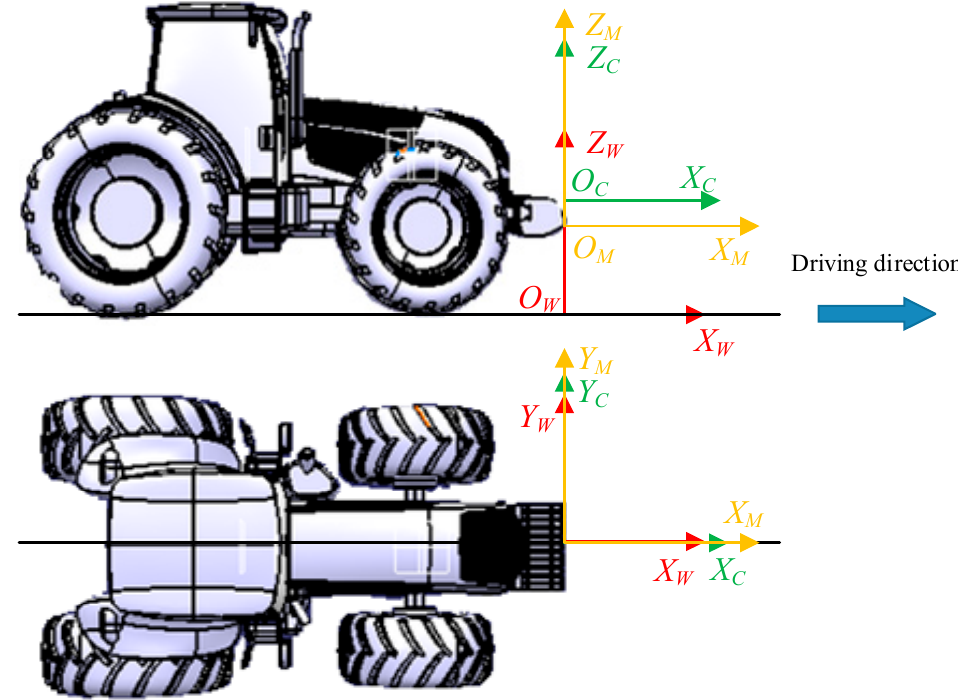
plane are parallel to the ground, and the X M -axis and the X C -axis are consistent with the driving direction of the tractor.